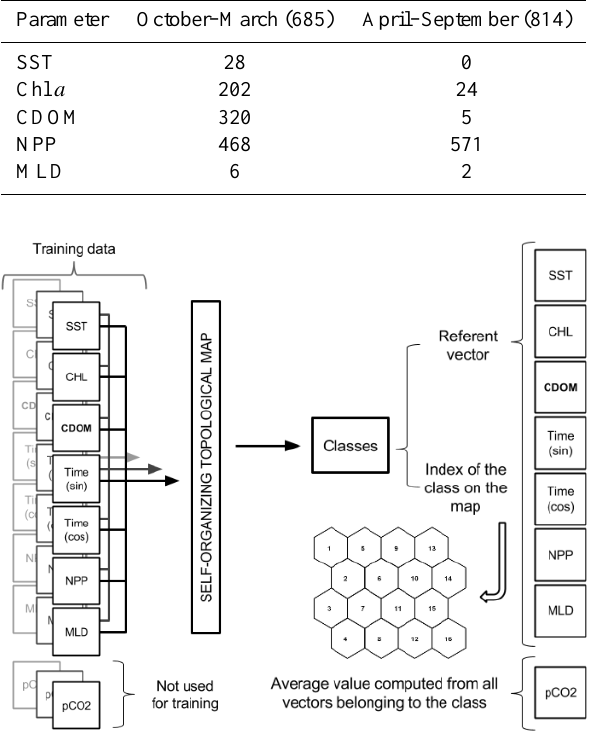
Figure 4. The various elements used in training a self-organizing map. On the left we have the data set used to train the SOM, which discretizes it into classes. Each class contains a referent vector con- taining, for each parameter, the average value of the elements com- prising it as well as an index of the class that informs us of its loca- tion on the topological